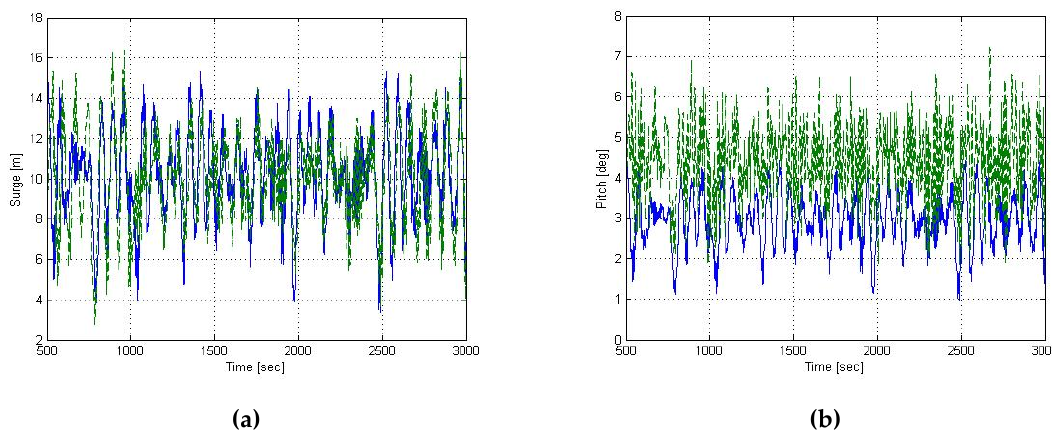
Figure 10. Platform responses time series of SWAY swivel and reference hinged model. (Solid blue: swivel model; Dash green: reference hinged model): ( a ) Surge. ( b ) Pitch.